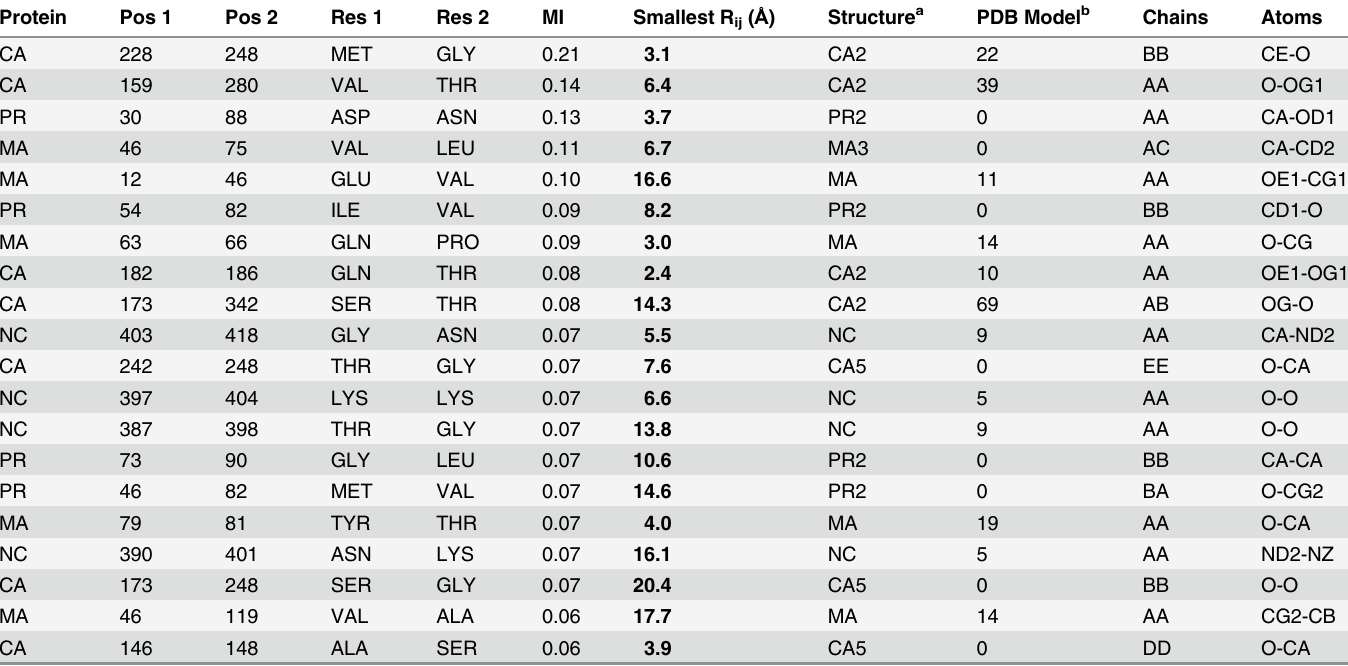
Listed are the smallest atom-atom distances (only heavy atoms, excluding side chains) for the most strongly correlated pairs of residues from the three regions PR-PR, Gag-PR, Gag-Gag ranked by MI in representative structures. For structures with multiple chains, inter-chain distances were computed and the chain and atom combinations of the smallest calculated distance for each pair are listed.